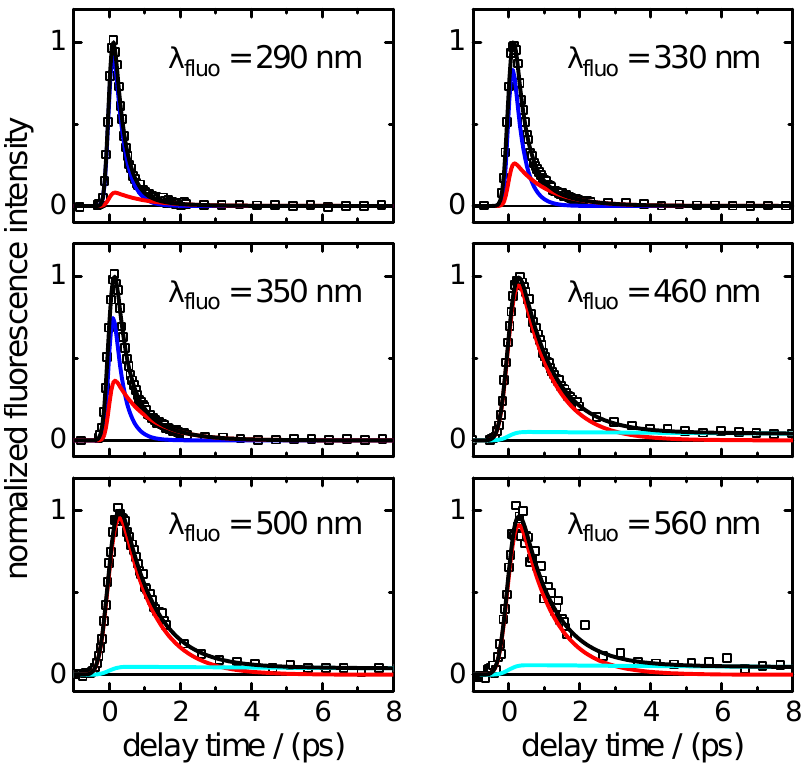
Figure 3. Fluorescence-time profiles of XMP after excitation at λ pump = 260 nm at six selected emission wavelengths in the range λ fluo = 290–560 nm. Open squares represent data points and black lines the overall fit functions. The single contributions are shown in blue ( τ 1,fluo ), red ( τ 2,fluo ) and cyan ( τ 3,fluo ). For clarity, the data points are displayed in the different panels only up to ∆ t = 8 ps, but were recorded in the experiment and analysed up to a delay time of ∆ t = 60